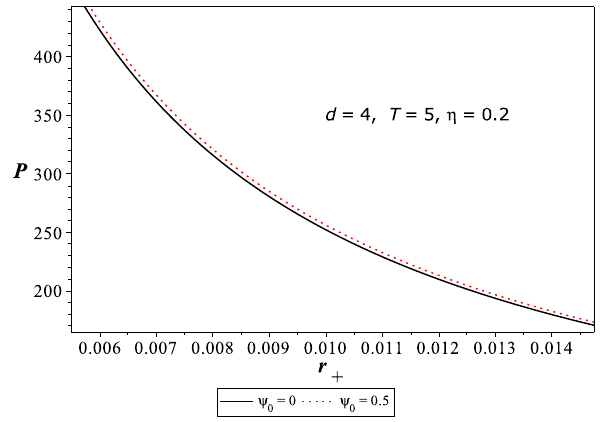
Fig. 8 P − r + diagram in the four-dimensional case for σ = 0 .